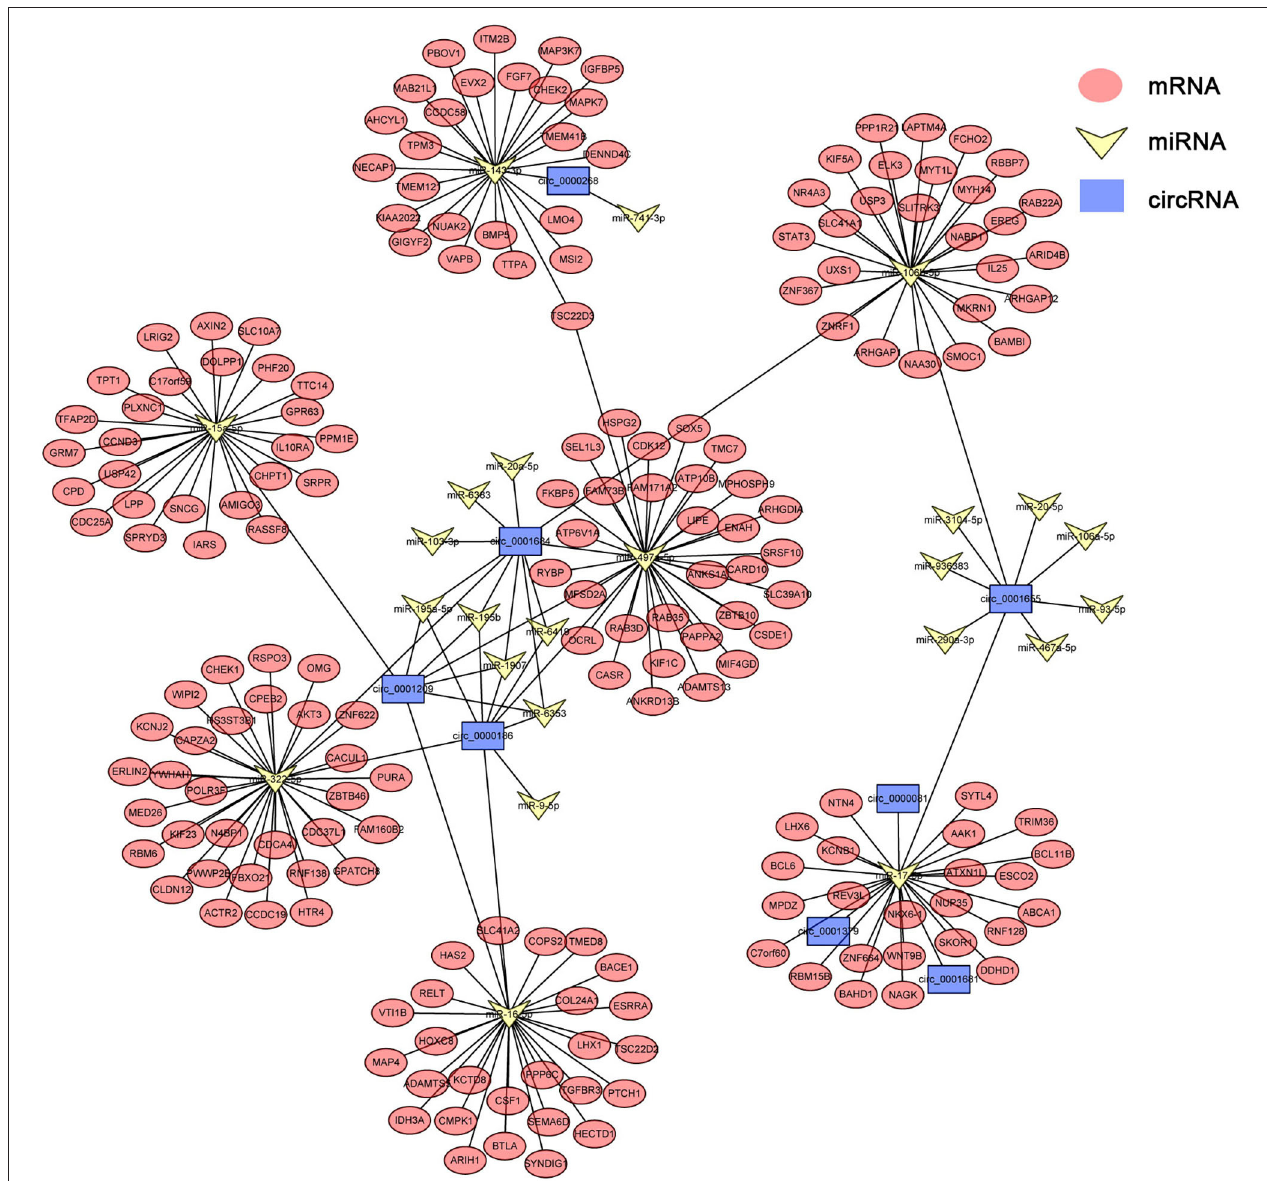
FIGURE 3 | circRNA–miRNA–mRNA network diagram of hepatocytes. Blue, yellow, and red nodes correspond to circRNAs, miRNAs, and mRNAs, respectively. The black lines correspond to the interactions between RNAs.